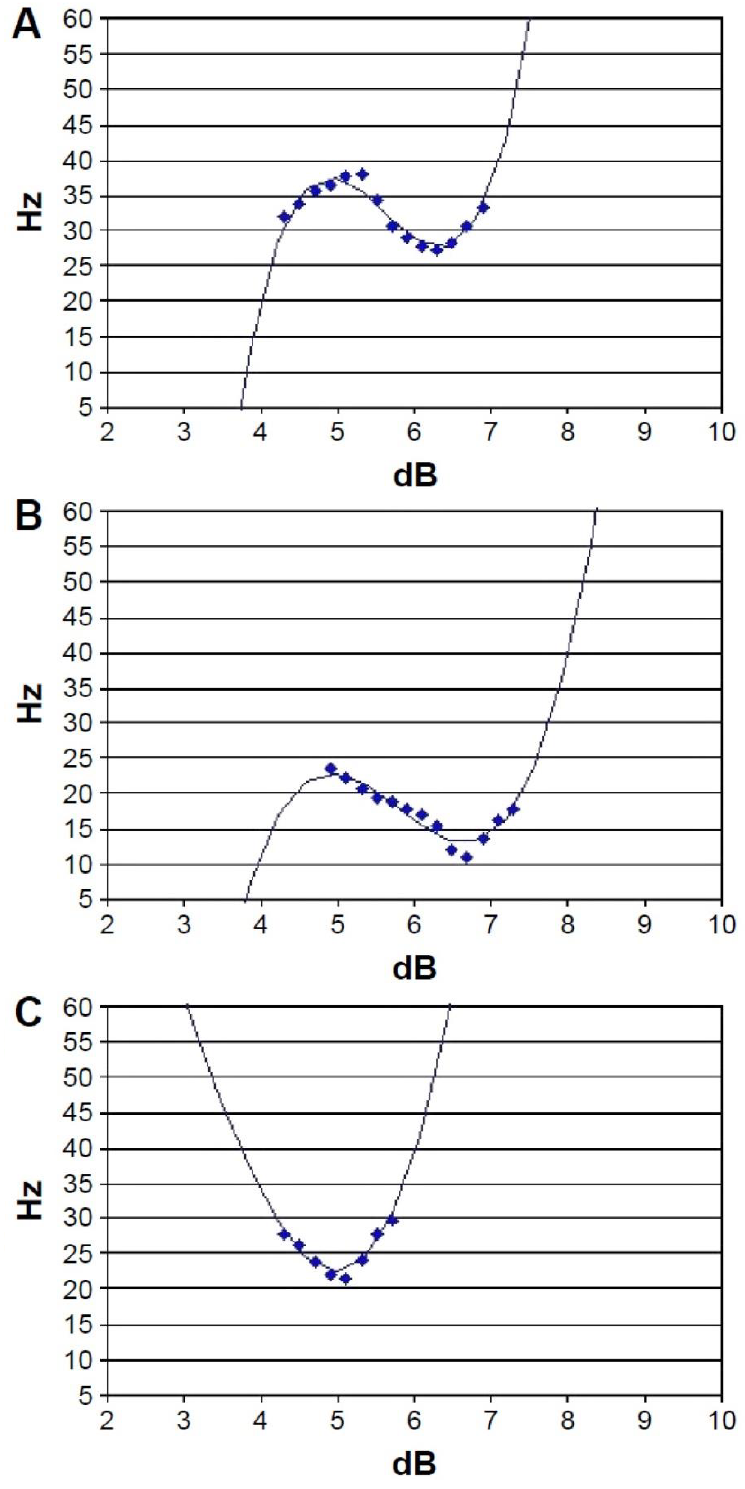
Figure 1. The output of subjects performing the MPSII. The panels ( A – C ) show various types of MPOD (macular pigment optical density) output graphs that are deemed acceptable, and have a lowest point and were considered acceptable.